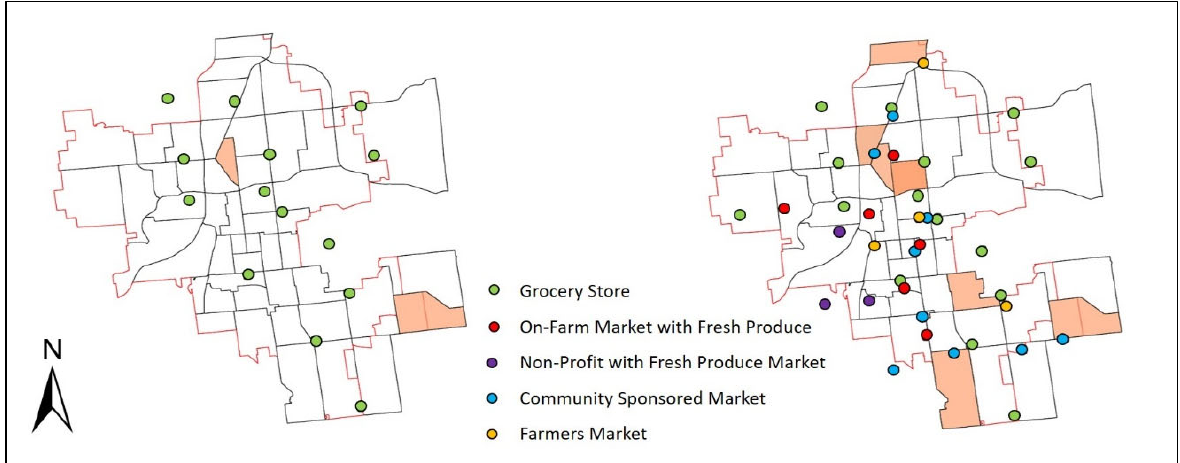
Figure 2. Grand Rapids 2010 (left) and 2015 (right), USDA Defined Food Deserts with Existing Supermarkets and Alternative Food Retail